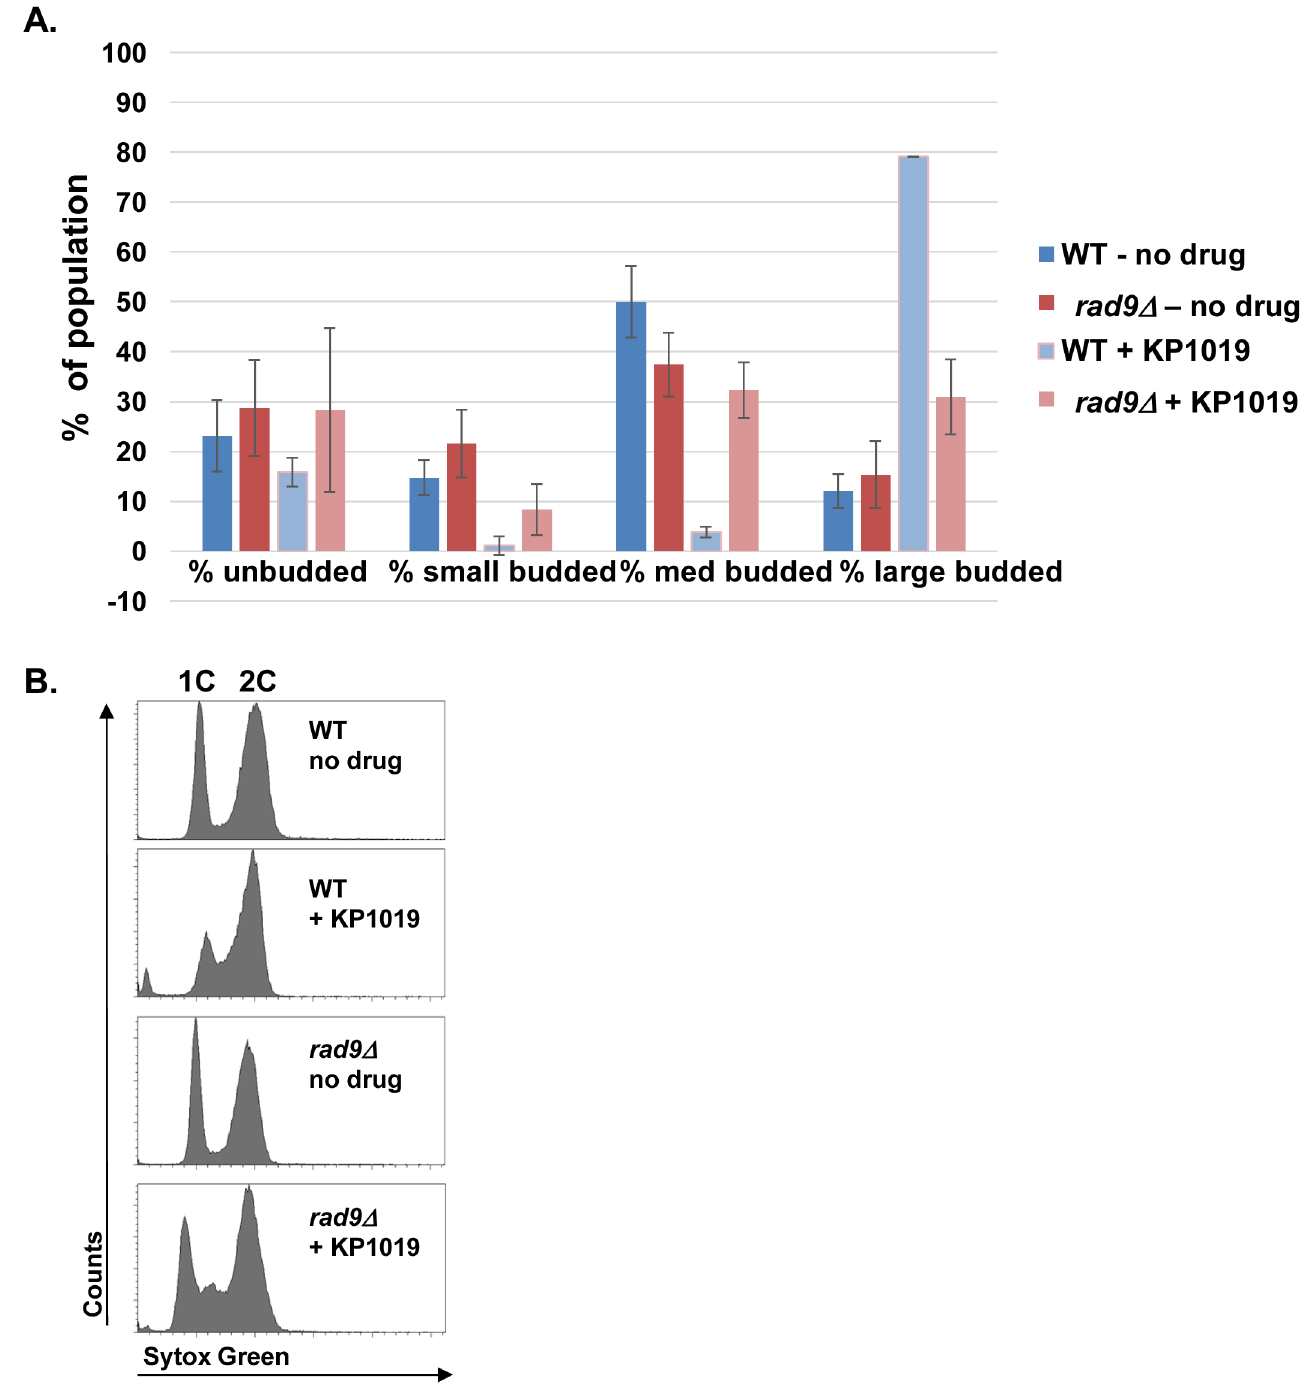
Fig 3. KP1019 induced cell cycle arrest requires RAD9 . A. MMY318-5A (WT) and rad9 deletion ( rad9 Δ ) strains were assayed for budding index and DNA content. Early log phase cells were untreated (- KP1019) or treated for 3 hours with 80 mg/mL KP1019 (+ KP1019) and assayed for budding index or DNA content as described in Materials and Methods. A. Cells were fixed and scored for % of unbudded cells, small budded, medium budded and large budded cells within the population. Untreated samples are represented by blue (WT) and red ( rad9 Δ ) bars, while treated samples are represented by light blue (WT) and light red ( rad9 Δ ) bars. The average of three replicates is presented with 2XSE error bar. B. DNA content measured by flow cytometry using Sytox green based staining of nucleic acid as described in Materials and Methods. The x-axis represents increasing amounts of Sytox Green signal while the y-axis represents number of cells. Position of 1C and 2C DNA content peaks is indicated at the top of the Fig. panels. C. The average % cells in the population scored as G0/G1, S, and G2/M using ModFit analysis of samples exampled in (B). Untreated samples are represented by blue (WT) and red ( rad9 Δ ) bars, while treated samples are represented by light blue (WT) and light red ( rad9 Δ ) bars. The average of three replicates is presented with 2XSE error